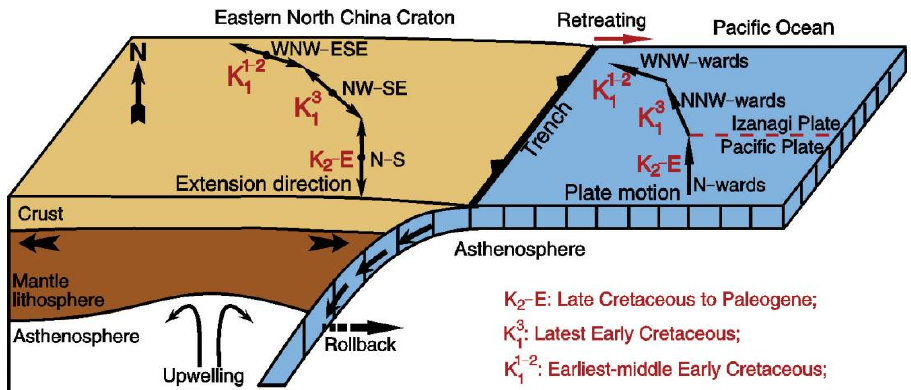
Figure 4. Map of Moho depth distribution of the NCC (modified from [35]).